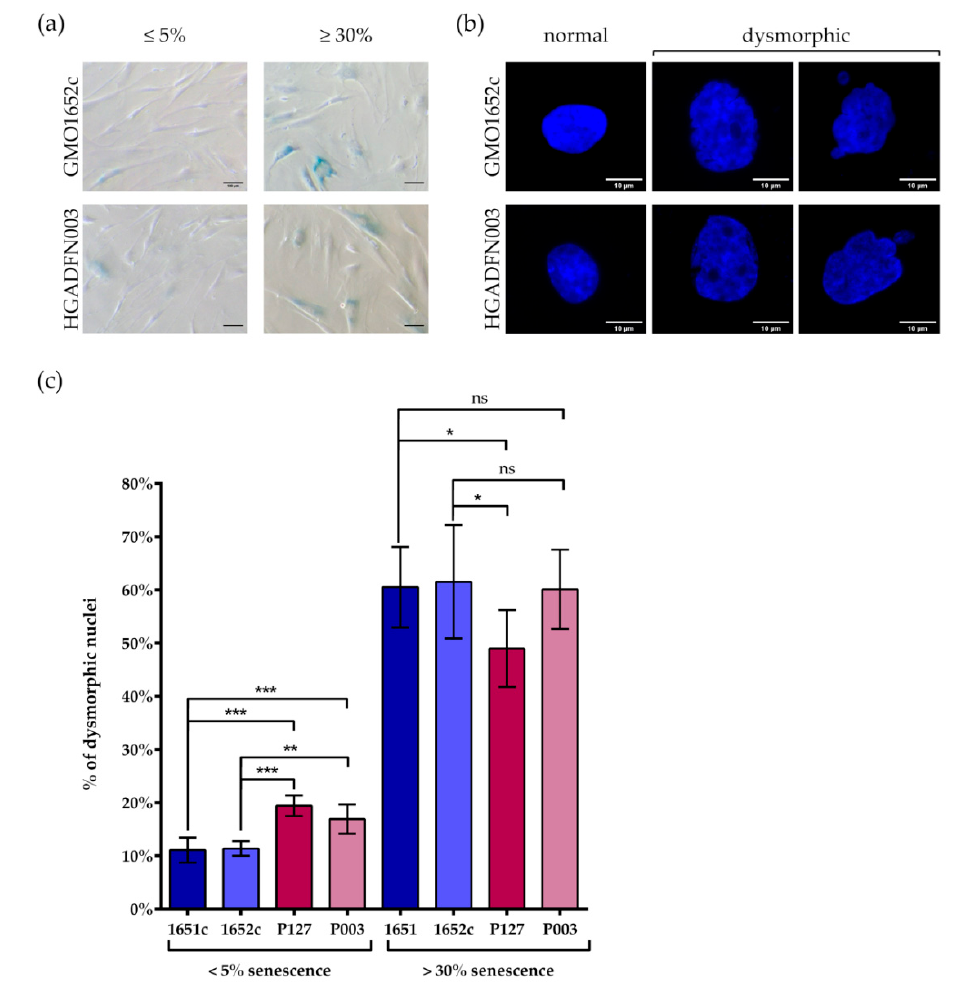
Figure 7. Number of dysmorphic nuclei increased with replicative senescence in both control and HGPS. ( a ) Representative images of SA- β -galactosidase stained cells. ( b ) Representative images of normal and dysmorphic nuclei counterstained with DAPI. ( c ) The number of dysmorphic cells in <5% and >30% control and HGPS fibroblasts, was determined by counting nuclei counterstained with DAPI. Comparisons within control or HGPS cell lines, with similar senescence, are not significant. At 5% senescence, HGPS passage numbers were ≤ P18, control cells were ≤ P21. At 30% senescence, control passages were ≥ P25, HGPS were ≥ P21. Values are presented as mean ± SD (n ≥ 3), not significant (ns) p > 0.05, * p < 0.05, ** p < 0.01, *** p < 001, one-way ANOVA with Tukey’s multiple comparison